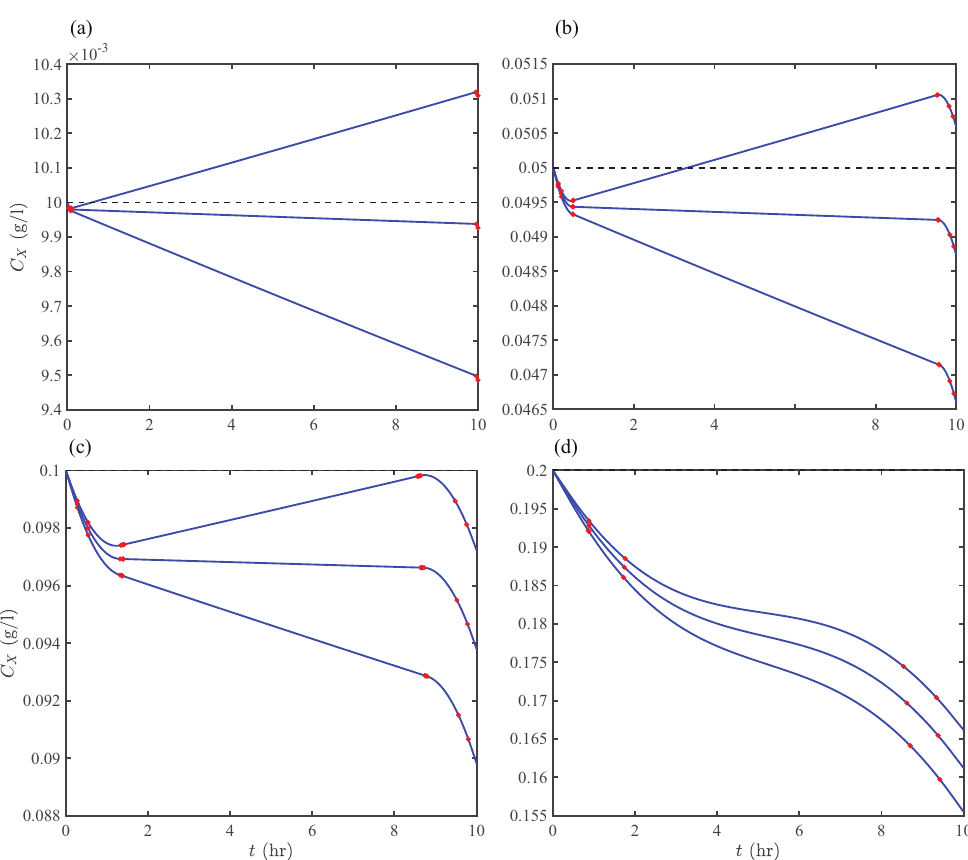
Figure 8. Time-varying concentrations of algae growing in an open pond with no algae in the inflow stream (e.g., the first pond in Figure 3) and operating at C CO h = 0.651 m, and f p = 10 h. Concentrations are plotted at ( a ) C ( i ) = 0.1 g/L, and ( d ) C ( i ) = 0.2 g/L. Red circles indicate transition points in the metabolic state C X X of algae.